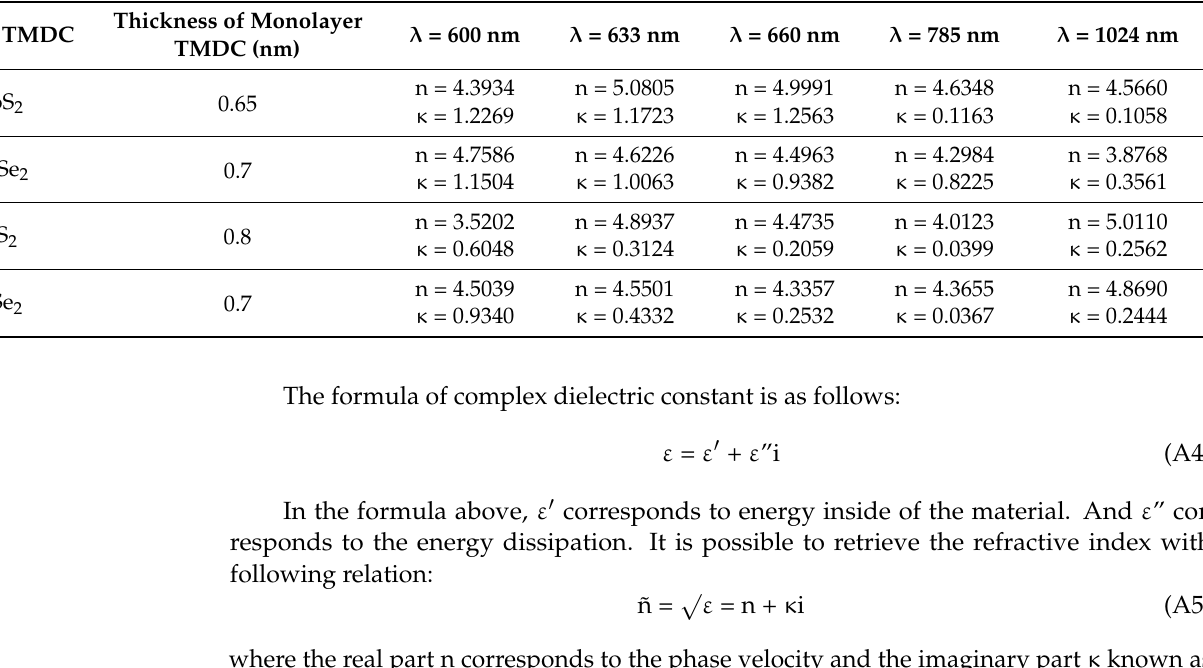
Table A1. The complex refractive indices of MoS 2 , MoSe 2 , WS 2 , and WSe 2 with different excitation wavelengths from 600 nm to 1024